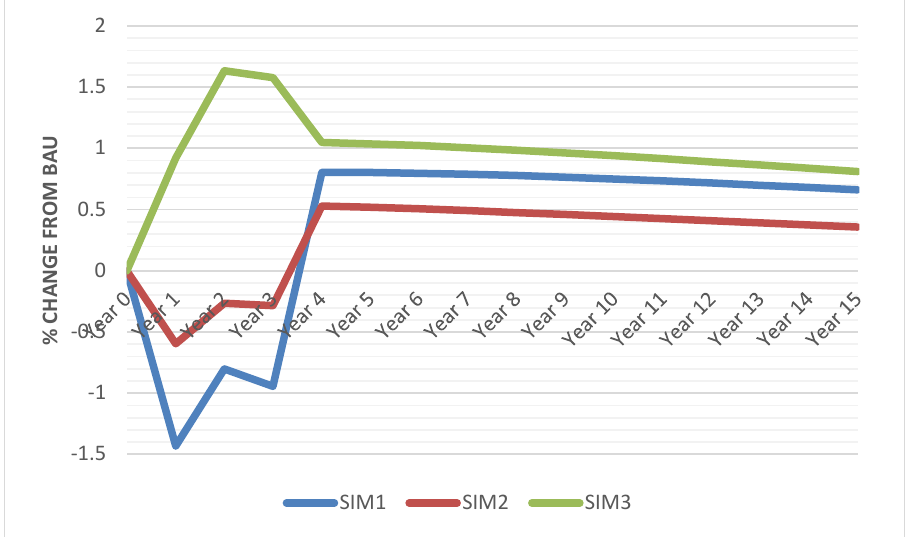
FIGURE 5: Impact on private investment expenditure (% change from BAU) Source: Authors’ calculations from simulation